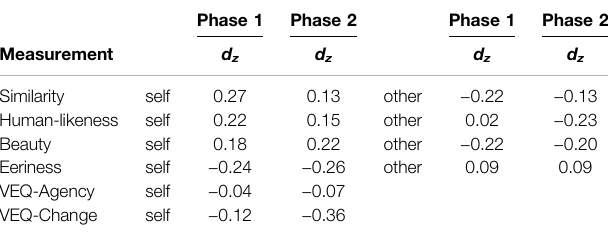
TABLE 3 | Effect sizes indicated by Cohen ’ s d z (Cohen, 1977) for the perception